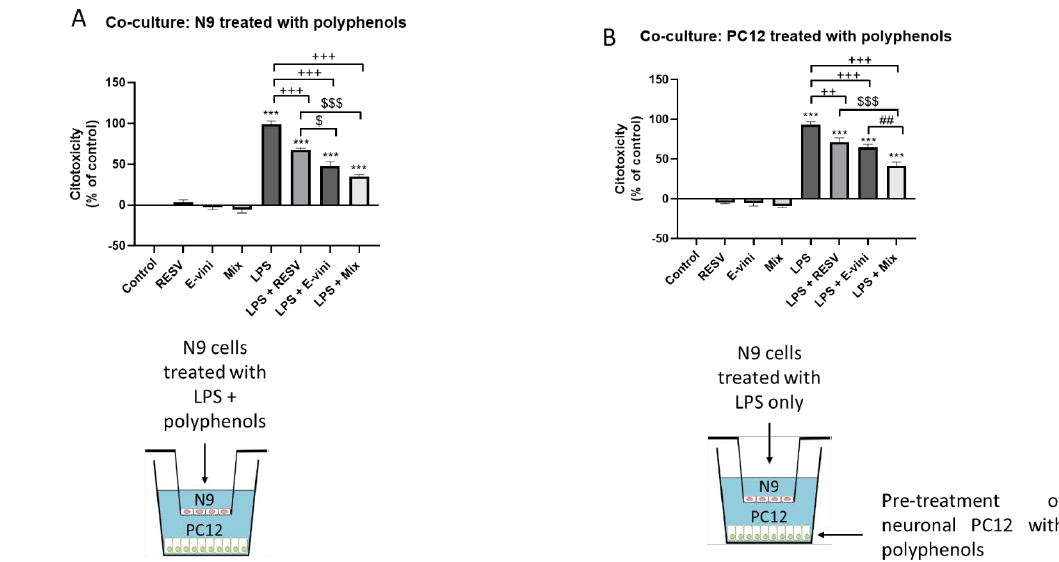
Figure 5. Co-culture of N9 microglial cells on neuronal PC12 cells. ( A ) N9 cells were pre-treated with polyphenols followed incubation with lipopolysaccharide (LPS), as described in the Materials and Methods. ( B ) N9 cells were treated with LPS and neuronal PC12 were pre-incubated with polyphenols as described in the Materials and Methods. Data are expressed as means ± SEM of three experiments. Asterisks (*) indicate statistical differences between the treatments and their respective controls (*** p < 0.001), plus signs (+) denote statistical differences between LPS and LPS in the presence of polyphenols. (+++ p < 0.001, ++ p < 0.01), dollar sign ($) indicates statistical difference between LPS + resveratrol and LPS + mixture of the two polyphenols ($$$ < 0.001, $ < 0.05) and number sign (#) indicates statistical difference between LPS + viniferin and LPS + mixture of the two polyphenols (## p < 0.01).